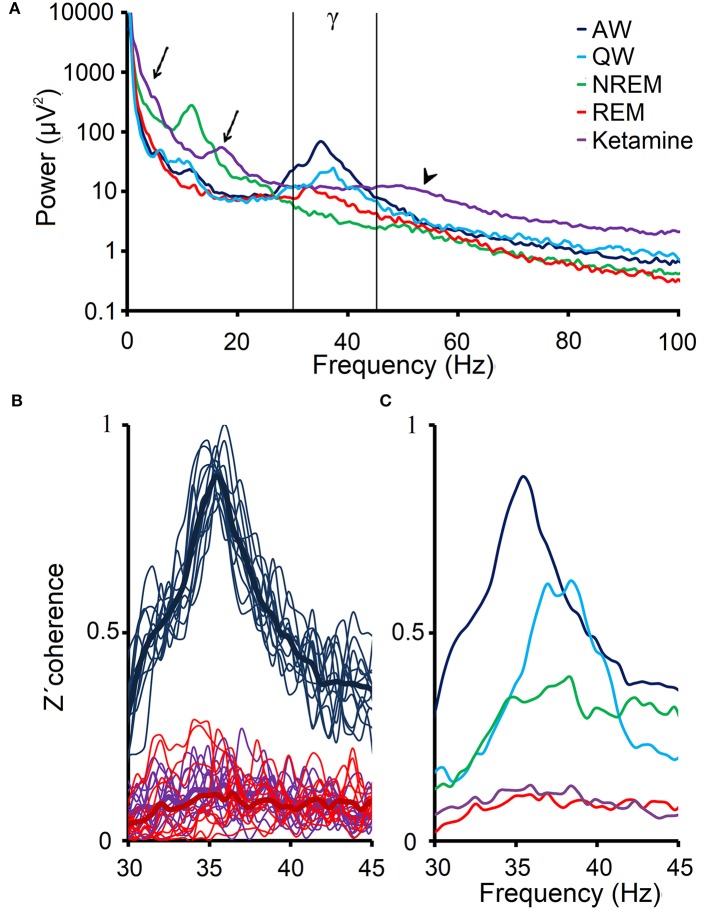
EEG gamma power and coherence under the effect of ketamine. (A) Power spectrum (0.5–100 Hz) that was obtained from the average of ten 100 s windows, from the prefrontal cortex EEG of C5 during alert (AW), quiet wakefulness (QW), NREM and REM sleep as well as following the administration of ketamine (15 mg/kg). The arrows show the delta and beta power peaks under ketamine, and the arrowhead shows the high gamma power under the drug. Low gamma band is shown between vertical lines. (B) 12 profiles of the z′-coherence (thin lines) between the prefrontal and posterior-parietal cortical areas of the C5, as well as the averages (thick lines) of these 12 profiles for AW, REM sleep and following administration of ketamine. (C) Average gamma z′-coherence profiles for the same conditions as in (A).